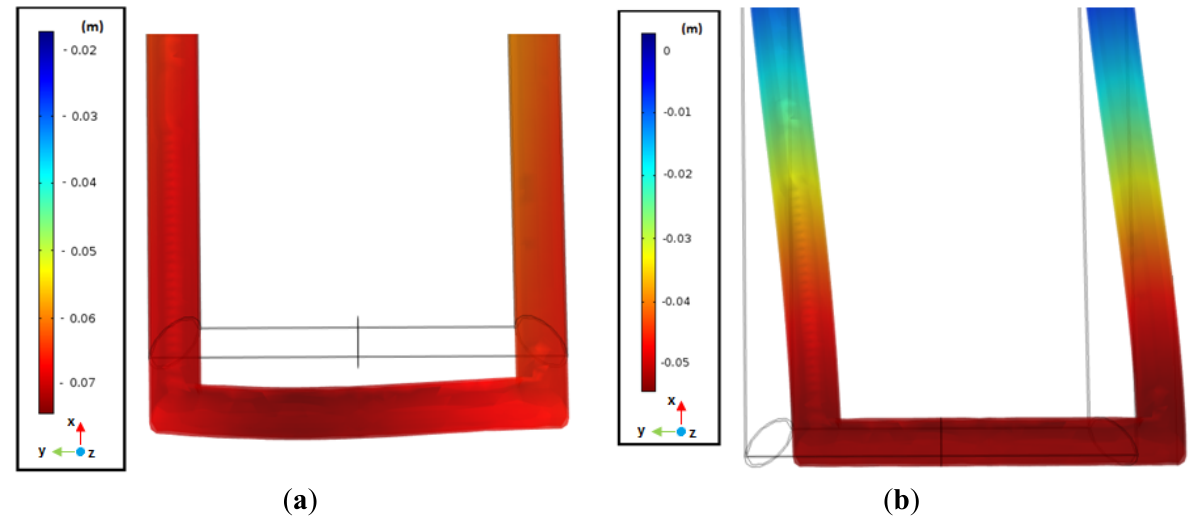
Figure 22. Deformed pipe at unsteady states: ( a ) in x -axis and ( b ) in y -axis.